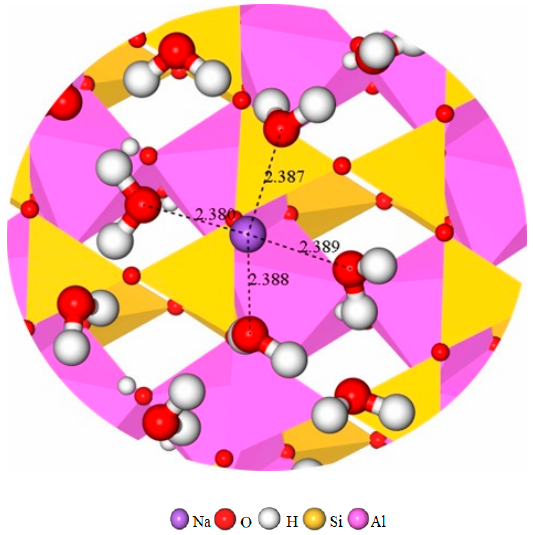
Figure 13. Na + coordinate with four H 2 O at a Van der Waals radius of 2.386 ± 0.004 Å in Na-MT1 0-6 .